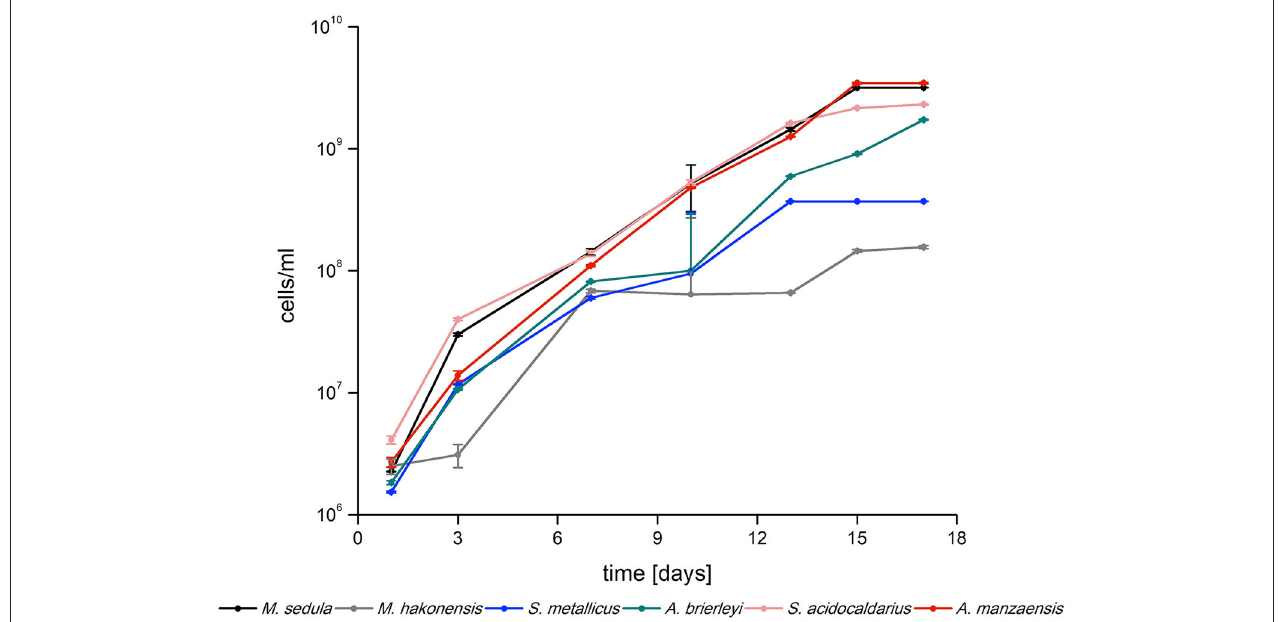
FIGURE 1 | Logarithmic growth curves of Sulfolobus spp., Metallosphaera spp., and Acidianus spp. grown on BOF-dust (10 g/L) over time ( n = 3).